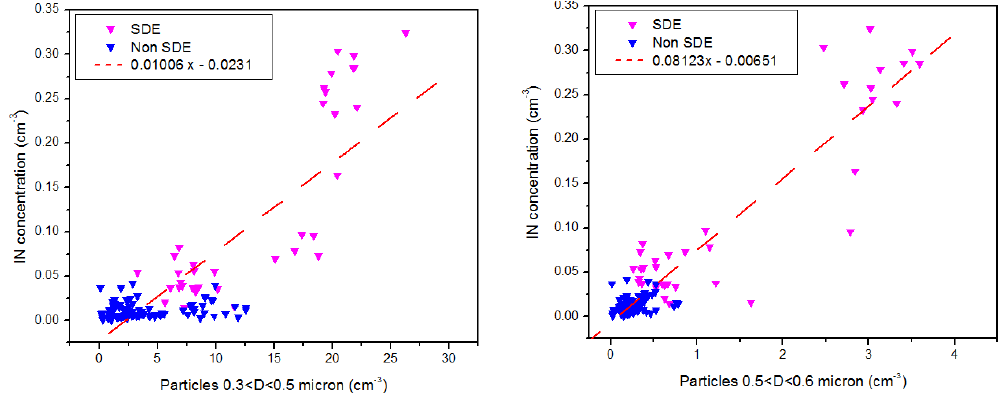
Fig. 11. IN number concentration versus particles number concentration of different size classes: blue triangles represents non SDE measurements and magenta ones, SDE measurements.